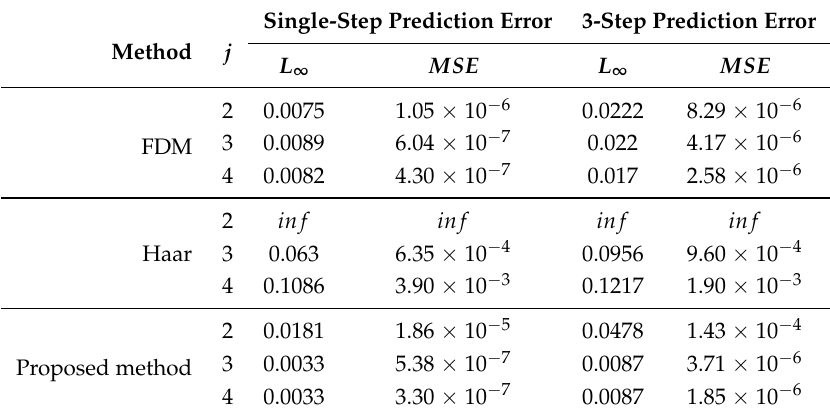
Table 2. A comparison of the three